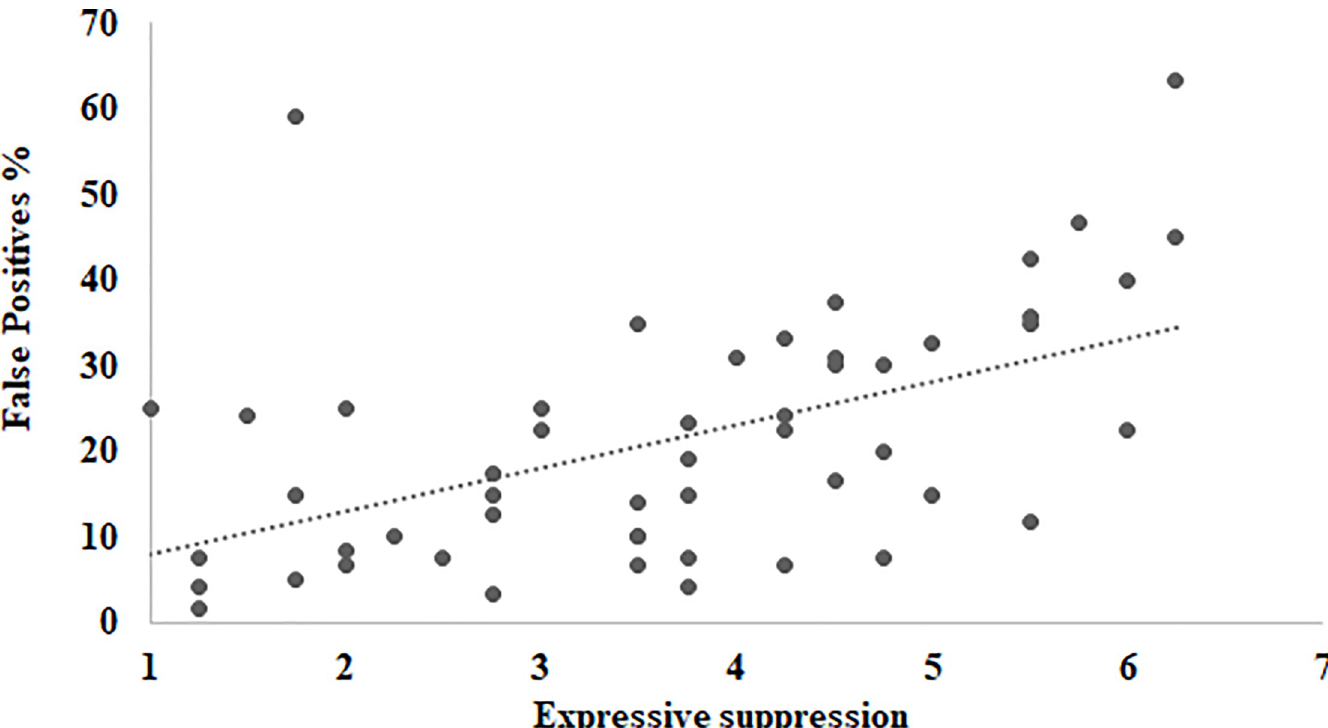
Fig 4. Scatter plots for the relationship between expressive suppression false positives in the overall face-matching task in Experiment 2. r (50) = .51, p < 0.001, with 95% confidence internals of .22 to .75.